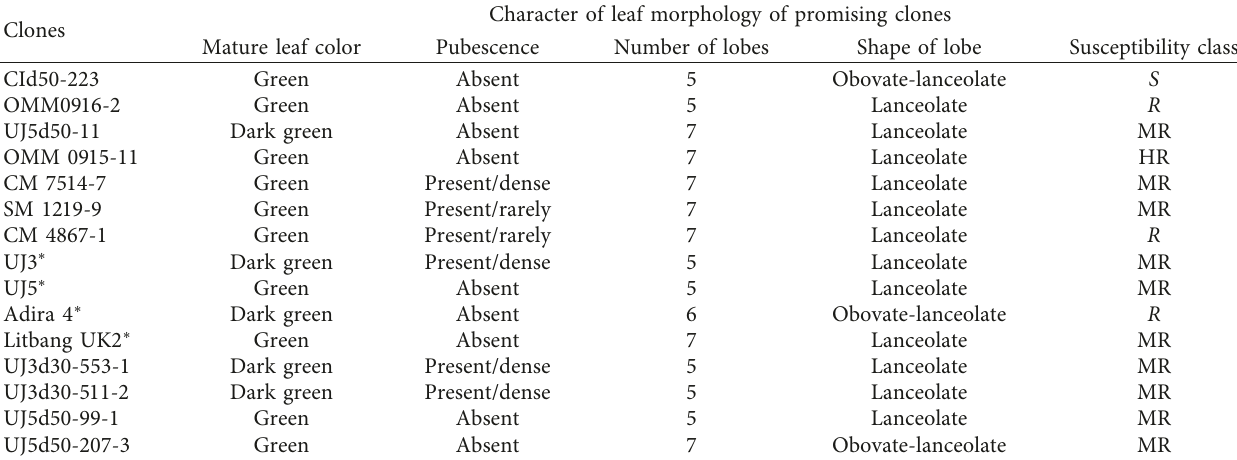
Table 6: Character of leaf morphology and susceptibility class of promising clones, green house of ILETRI, 2018. Clones Mature leaf